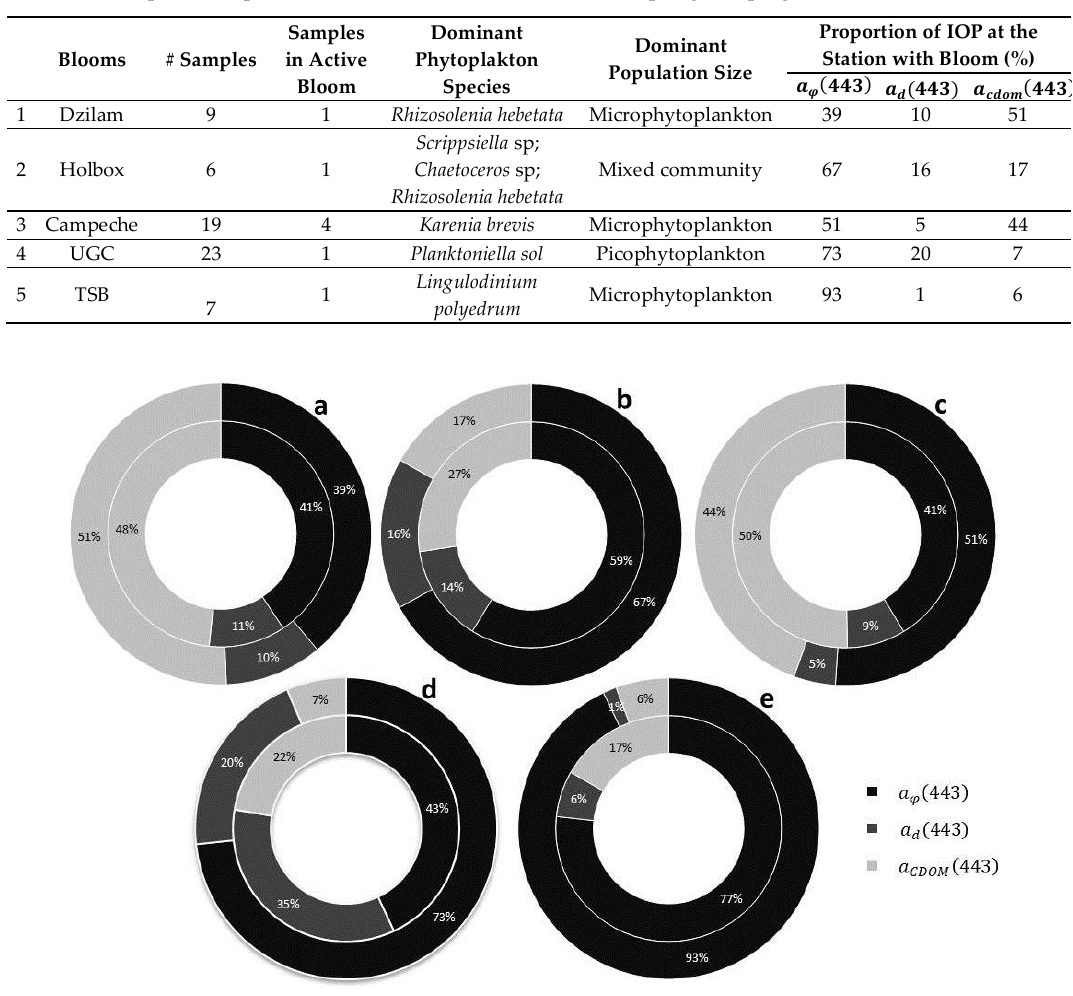
Table 1. Characterization of bloom events. The absorption coefficient that contributes most to the Inherent Optical Properties (IOPs) is underlined for each sampling campaign.